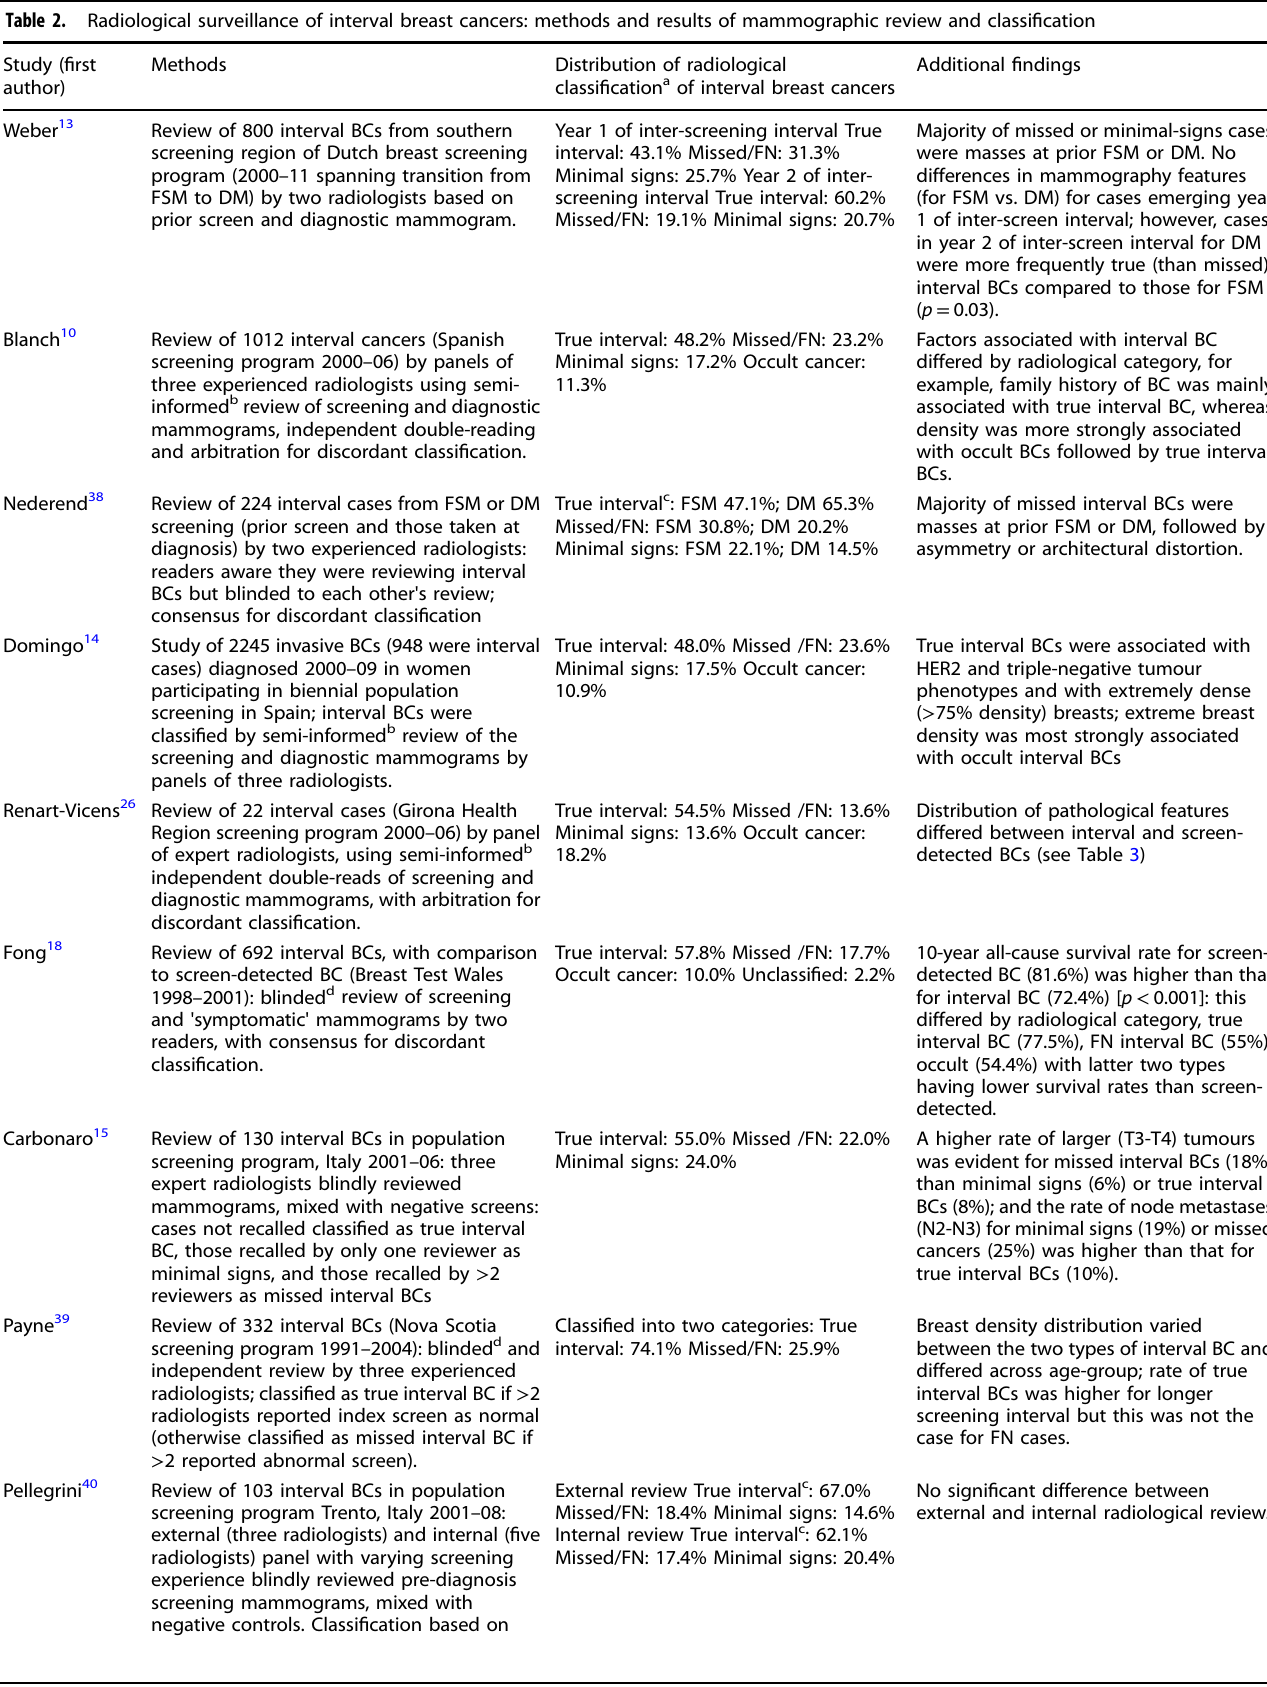
Table 2. Radiological surveillance of interval breast cancers: methods and results of mammographic review and classi fi cation Study ( fi rst